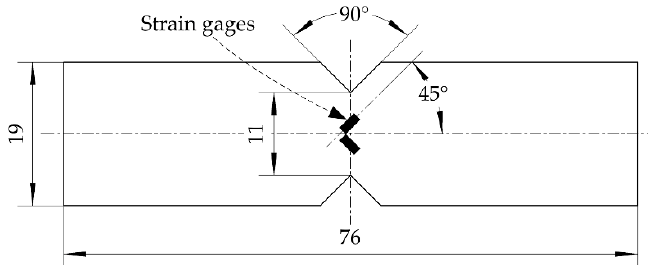
Figure A4. Dimensions of the V-notched shear specimens (mm).